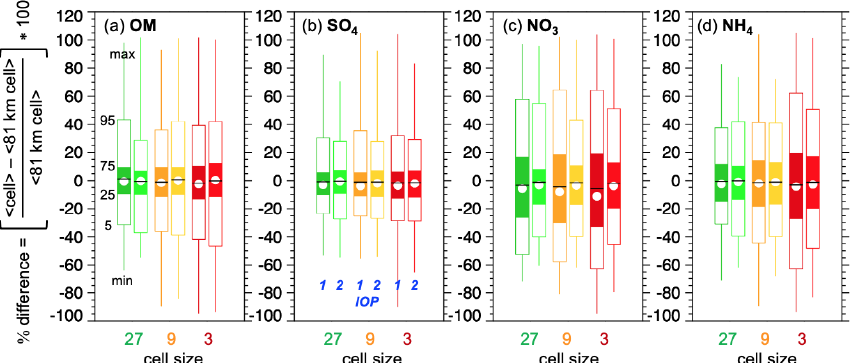
Figure 5. Percent difference between the SGP 81km cell average and the 27, 9, and 3km cell averages of (a) OM, (b) SO 4 , (c) NO 3 , and (d) NH 4 concentrations from the AMS instrument expressed as percentiles where the white circles denote the median values. All flights during IOPs 1 and 2 are grouped by the darker (left) and lighter (right) colors, respectively. Filled boxes denote values falling within the 25th to 75th percentiles, open boxes denote values falling within the 5th to 95th percentiles, vertical lines denote minimum and maximum values, and the black horizonal lines denote the mean